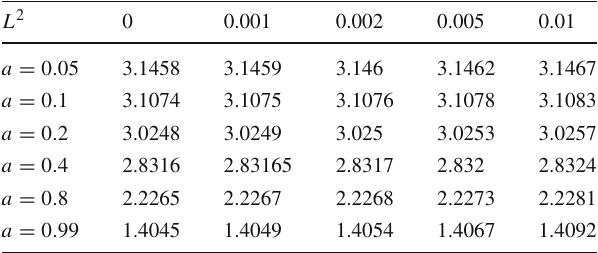
Table2 Theinnermoststablecircularorbitsofparticlesmovingaround a rotating black hole (case for ω B = 0 . 25 and M =